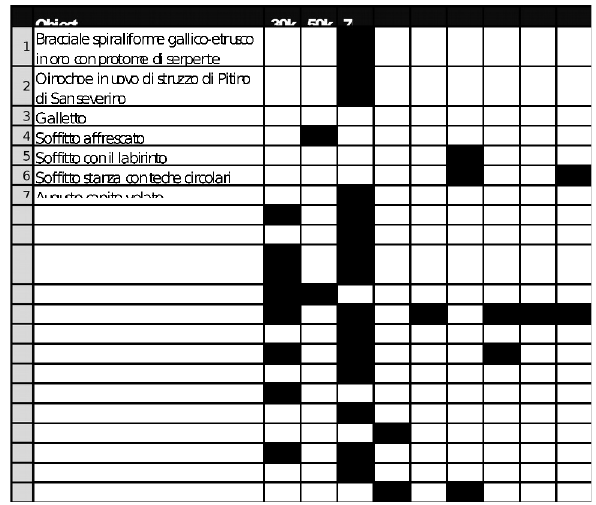
Figure 3. 3D models for Digital Library. Table with archaeological artefacts and model size: different sizes for different